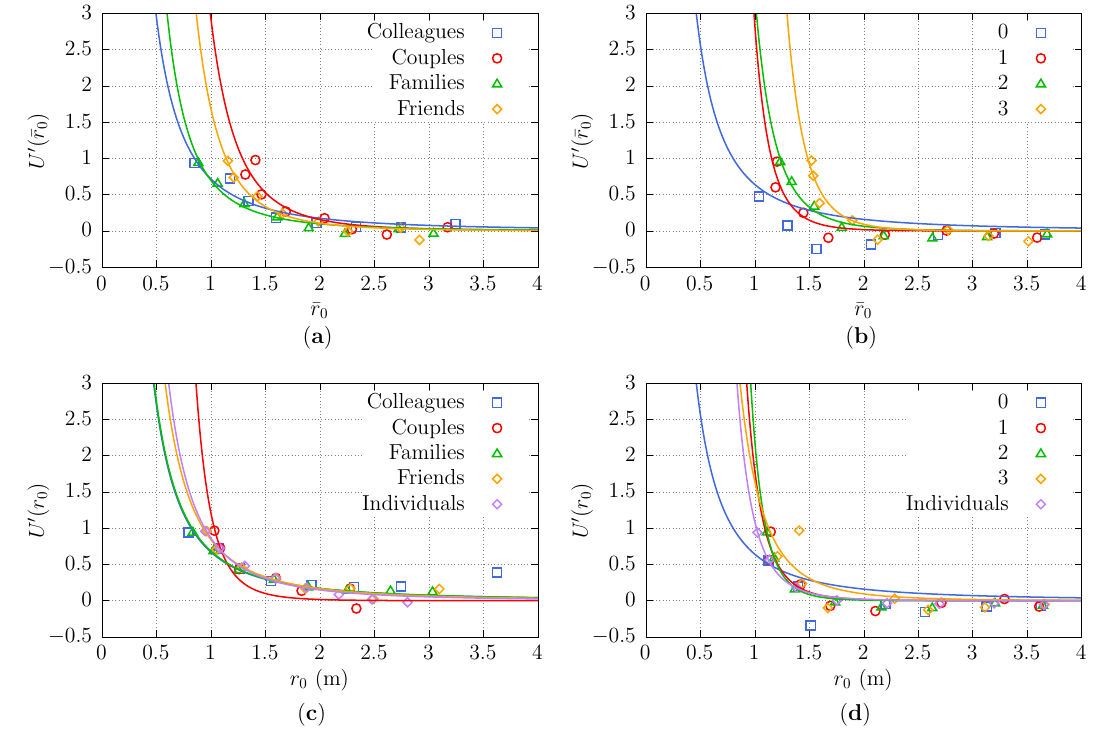
′ ( r Figure 7. Collision avoidance potential U 0 ) ( a ) for various social relations and ( b ) intensities of interaction of the group. Dashed lines correspond to a power function fit of the quantized data. Collision avoidance ′ ( r potential U 0 ) ( c ) for various social relations and ( d ) intensities of interaction of the group. Dashed lines correspond to an exponential fit of the quantized data. ( c,d ) report a comparison to individual-individual (non- group) interaction using non-scaled